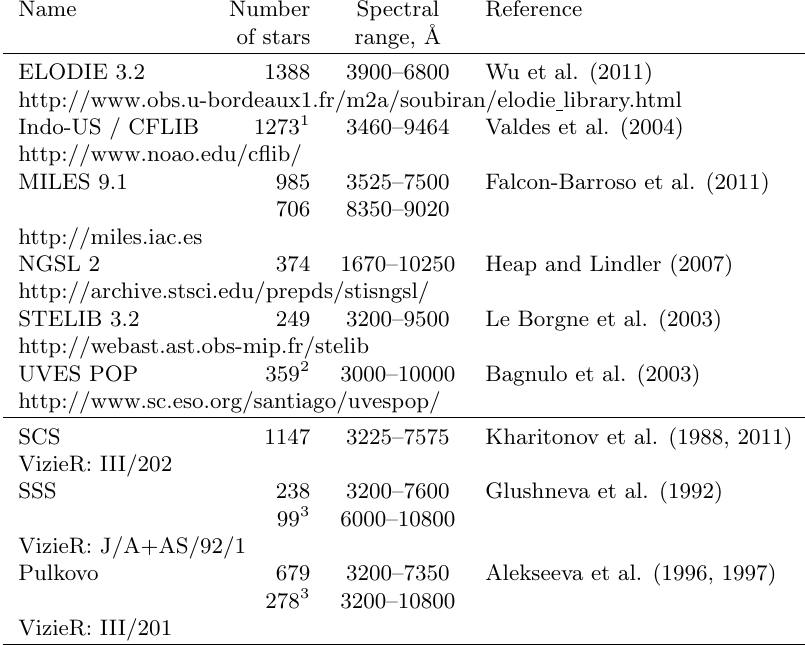
Table 2. Empirical spectral atlases.